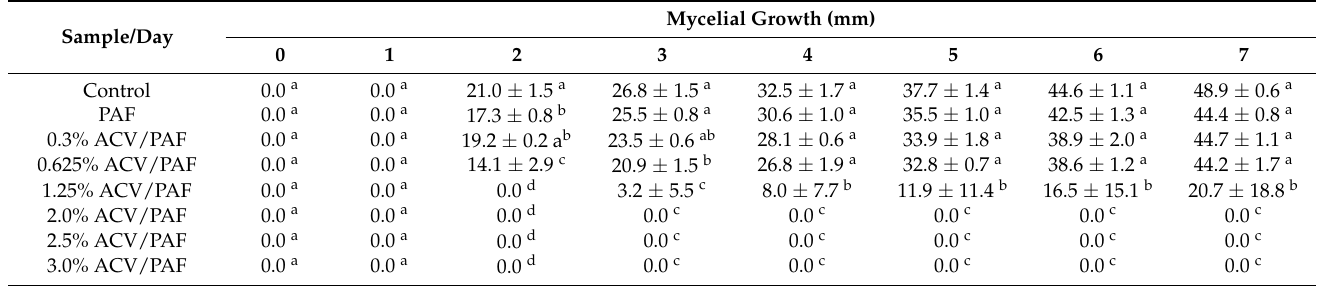
Table 2. Mycelial diameter (mm) of the A. niger fungi in the PAF and ACV/PAF adhesives. The results are reported as mean ± SD, while the group classifications (a, b, c, and d) within each column are listed based on the statistical analysis (significant differences; p ≤ 0.05) by using a Duncan’s multiple range test. The statistical analysis was conducted on each of the data columns.